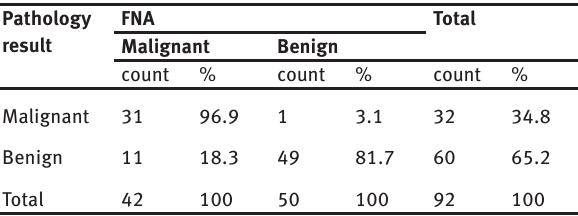
Table 1: Coordination of pathological and FNA results in